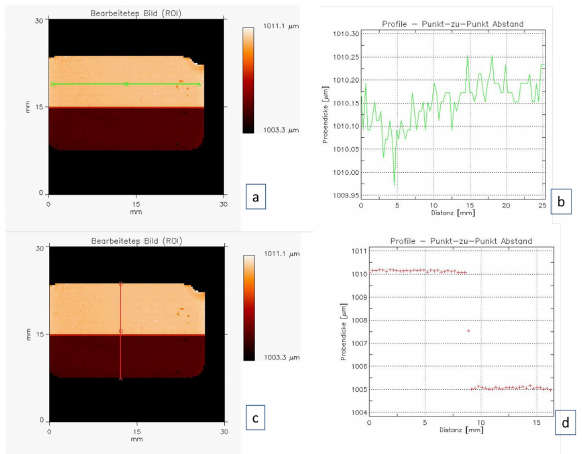
Fig. 4. 2D colour-coded thickness data of the test step with profile lines parallel to the plane in 4a and across the step in 4c. 4b and 4d show the thickness data along the profile lines.